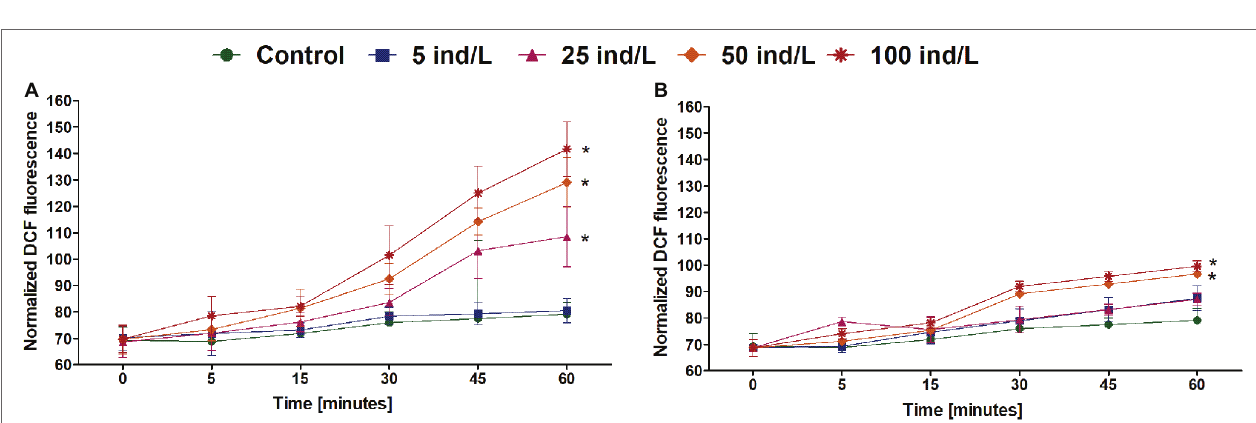
FIGURE 2 | The intracellular reactive oxygen species (ROS) level (mean and SD) of M. aeruginosa exposed for 7 days to different concentrations of D. magna (A) and D. cucullata (B) ( n = 5). An asterisk indicates a significant difference with the control ( p < 0.05; Mann-Whitney U